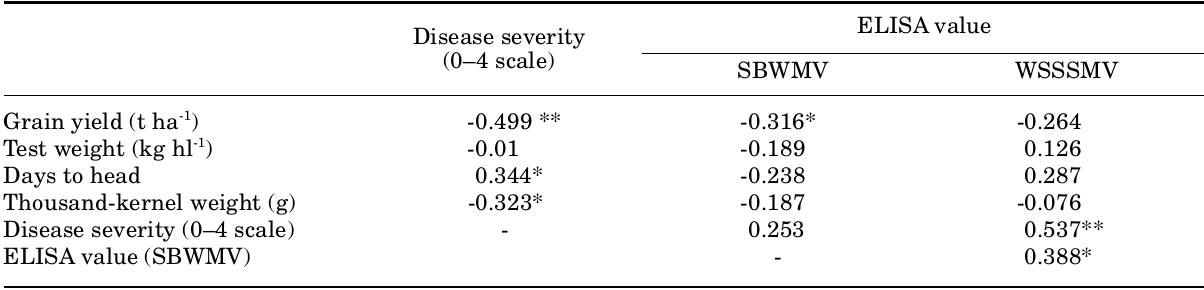
Table 2. Simple correlation coefficients between disease severity, ELISA values and various agronomic characters for 43 cultivars of durum wheat grown in a field infected with both SBWMV and WSSMV near Rome, Italy, in